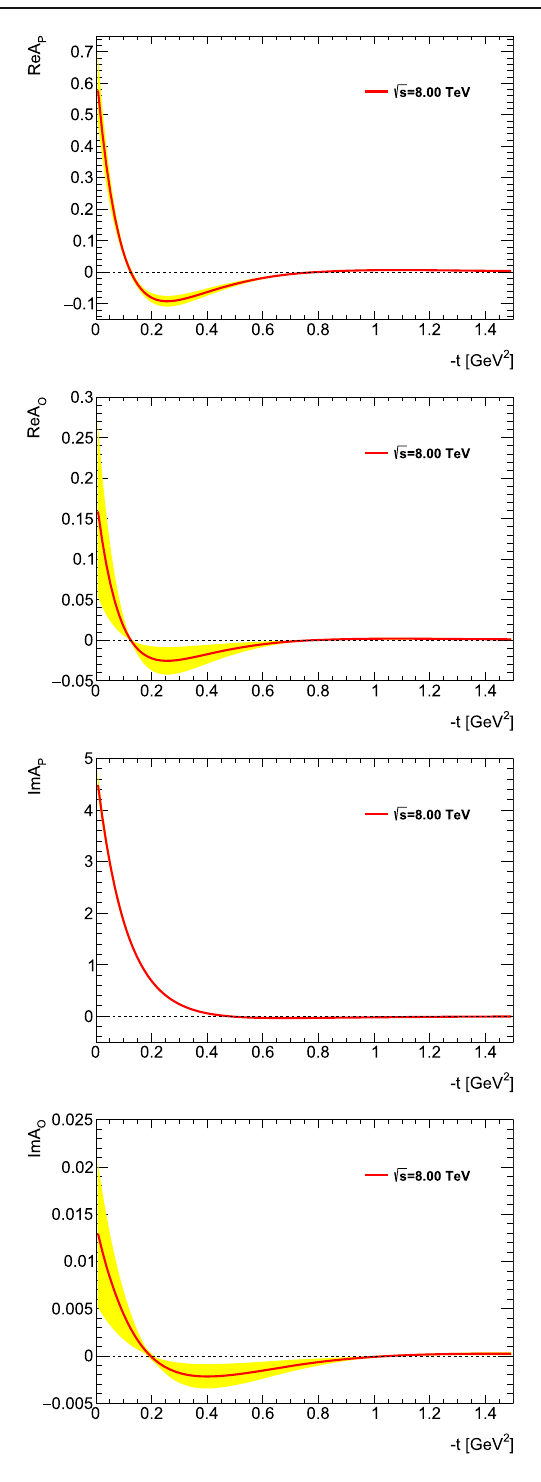
Fig. 3 Real and imaginary parts of the Pomeron (C-even) and Odd- eron (C-odd) components of the scattering amplitude at calculated from the ReBB model using the energy calibration of the fit parameters done in Ref. [1]. Yellow band indicates the systematic errors of the calculation. The ReBB model is validated in a limited − t range, as detailed in Ref. [1], hence we consider its predictions in the small- | t | region on the qualitative level, only